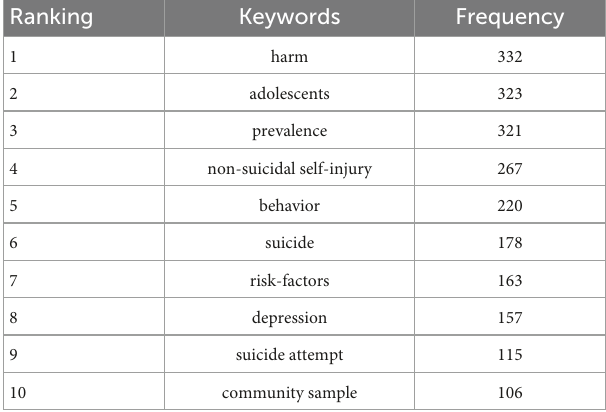
TABLE 7 Top 10 keywords in terms of frequency of non-suicidal self-injury (NSSI). Ranking